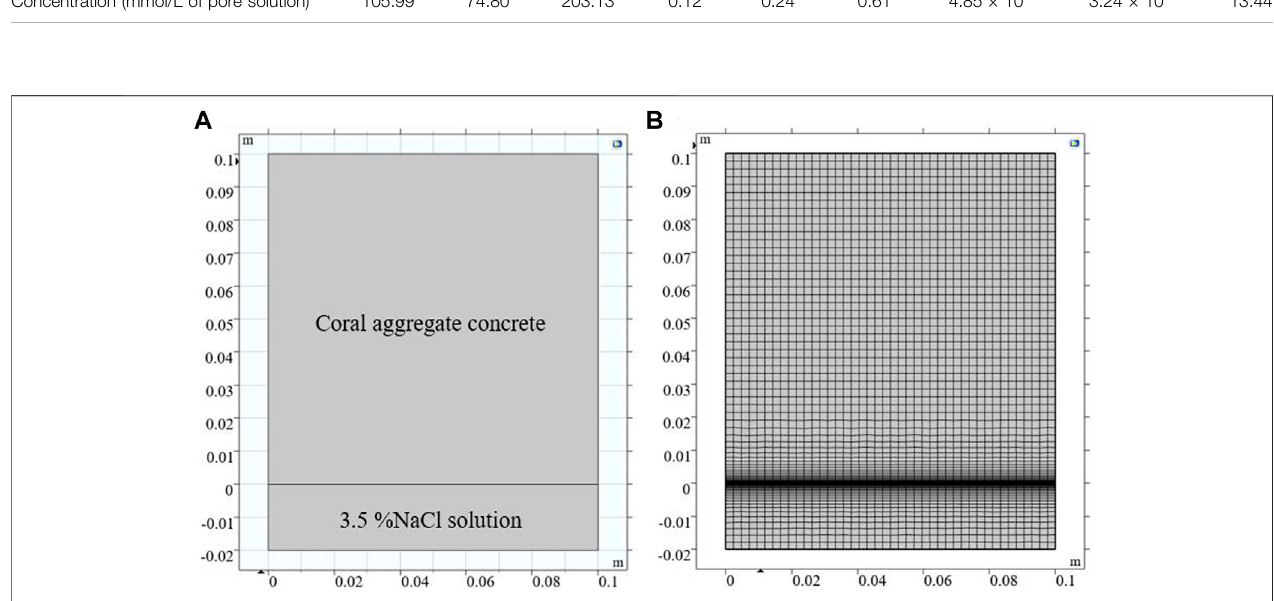
FIGURE 3 | (A) Geometrical model; (B) fi nite element